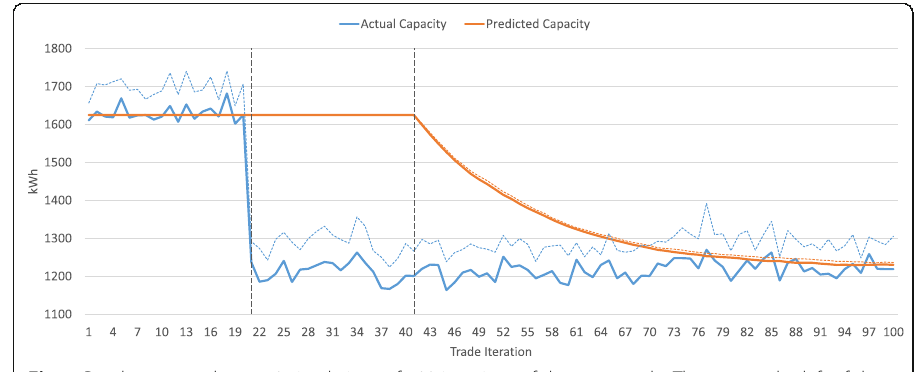
Fig. 7 Results averaged over 10 simulations of 100 iterations of the same trade. The area to the left of the dashed lines is using the default configuration, the area between the dashed lines is with user type B reliability P (D n ) at 0.5 and the area to the right of the dashed lines is with learning enabled. Dotted lines show + 1 standard deviation